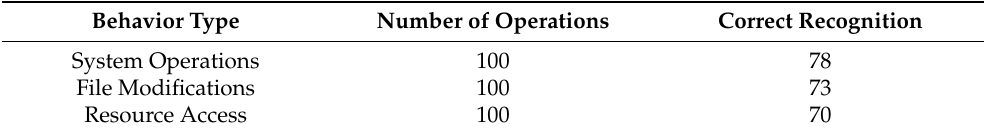
Table 4. Accuracy of user behavior recognition.